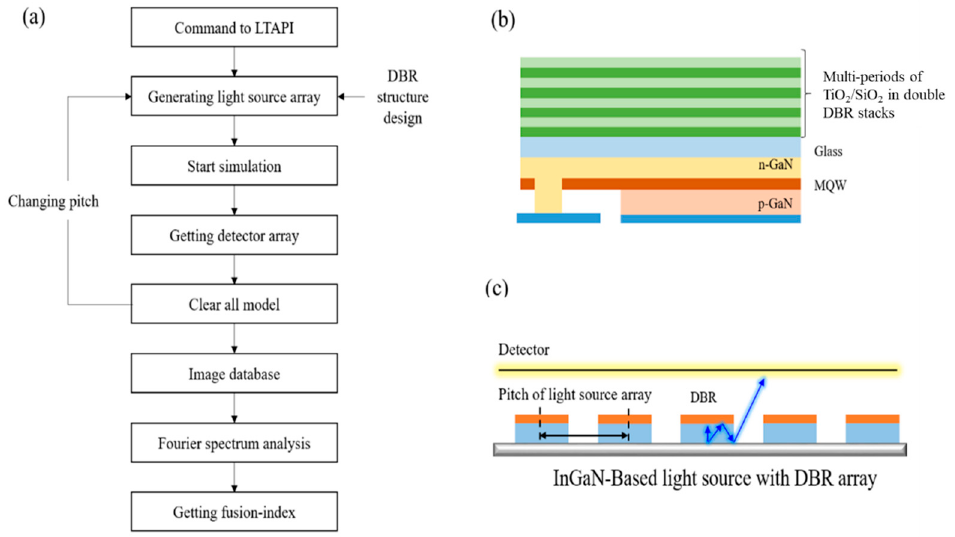
Figure 2. ( a ) Modeling flow. ( b ) Single light source with distributed Bragg reflector (DBR) modeling. ( c ) Light source array modeling. ( c ) Light source array